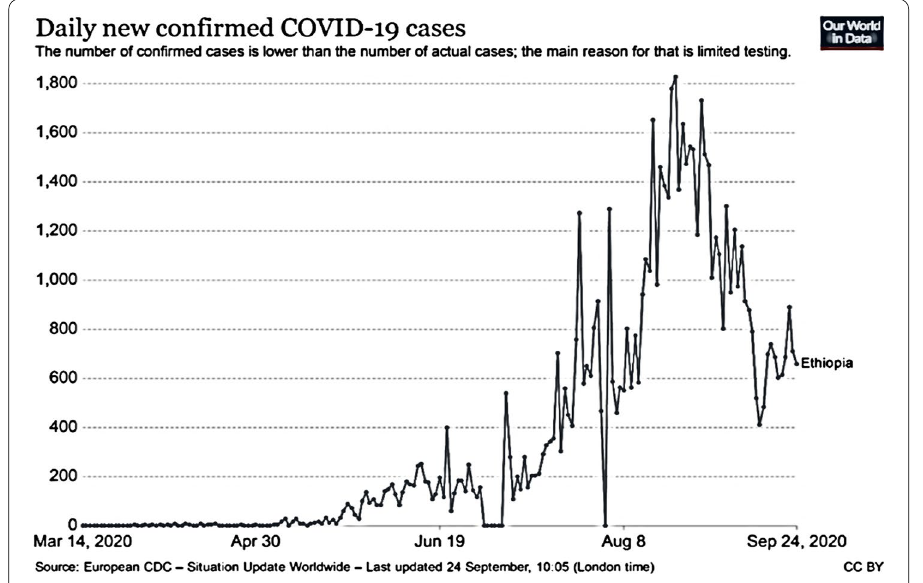
Fig. 2 Daily new confirmed COVID-19 cases up to Sep, 24,